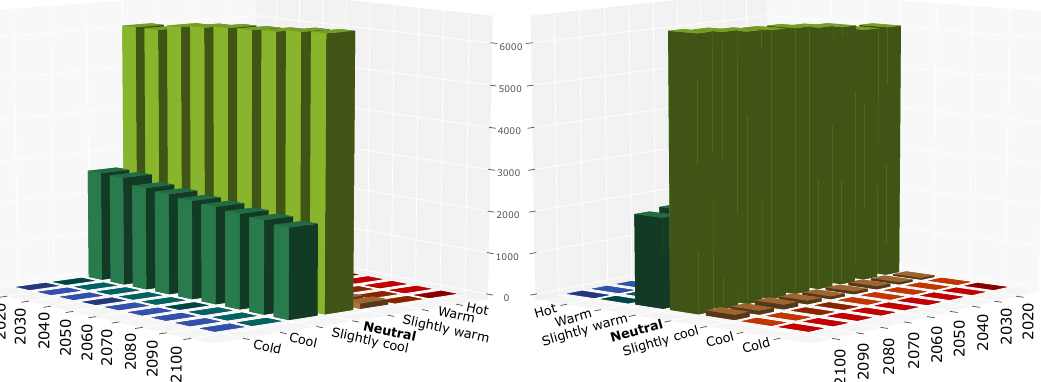
Figure A4. Comfort results taking into account the NBE CTE-79 standard and the Pamplona weather file generated with Meteonorm based on the IPCC scenario